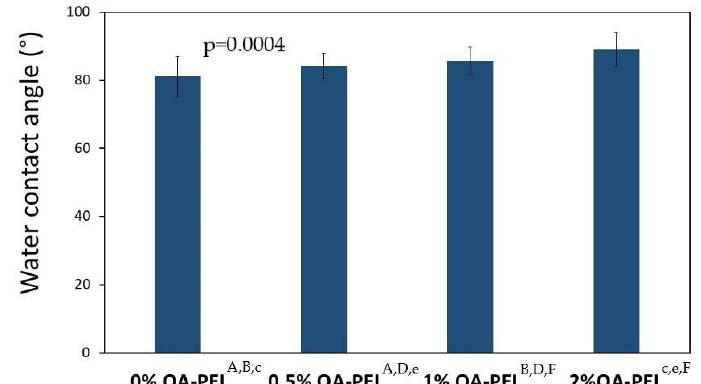
Figure 13. WCA values of the surfaces. Statistically significant differences ( p ≤ 0.05) are marked with the lower case letters, whereas statistically insignificant differences ( p > 0.05) are marked with the upper case letters.